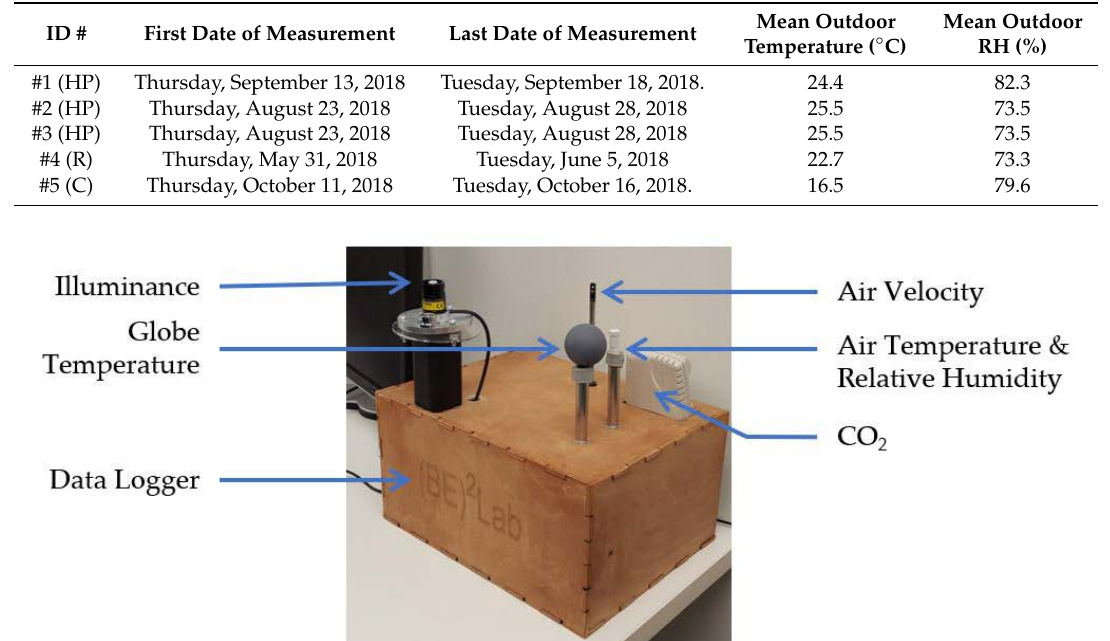
Table 4. Measurement Period of Each School.